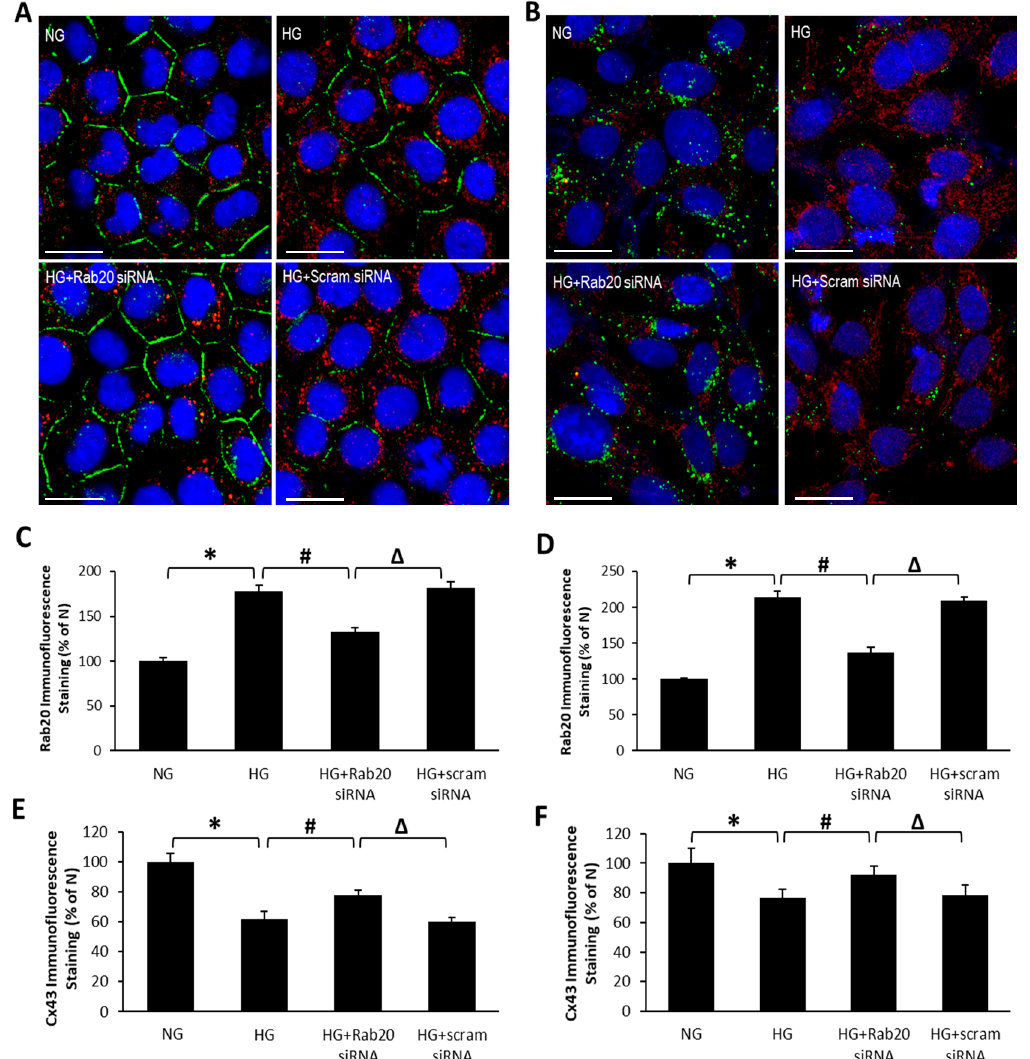
Figure 2. Rab20 siRNA attenuates HG-induced downregulation of connexin 43 (Cx43) expression. Representative images show decreased Cx43 immunoreactivity (green) and increased Rab20 immunoreactivity (red) in ( A ) RRECs and ( B ) rMC-1. Scale bar = 25 μ m. Cells transfected with Rab20 siRNA restores Cx43 level. Graphical illustration of cumulative immunofluorescence data shows HG increases Rab20 immunostaining in ( C ) RRECs and ( D ) rMC-1, and that Rab20 siRNA prevents HG-induced decrease in Cx43 plaques in ( E ) RRECs and ( F ) rMC-1. Data are expressed as mean ± SD. * p < 0.05, n = 6; # p < 0.05, n = 6; Δ p < 0.05, n = 6.